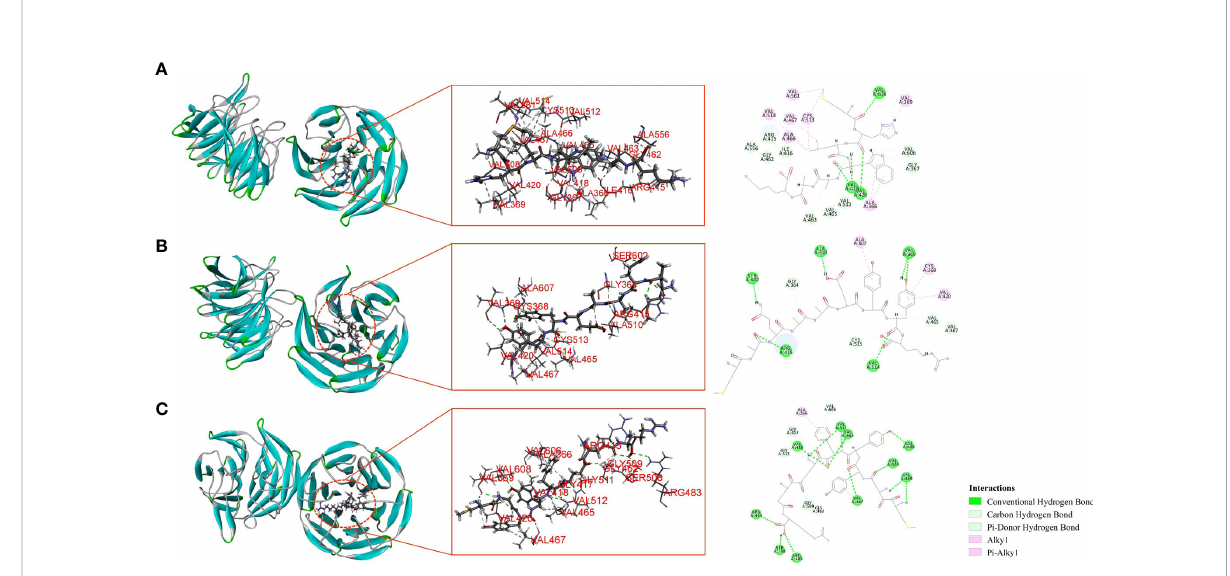
FIGURE 7 Molecular interactions between Keap1 and antioxidant peptides. MHLWAAK (A) , MAQAAEYYR (B) , and MDYYFEER (C) .